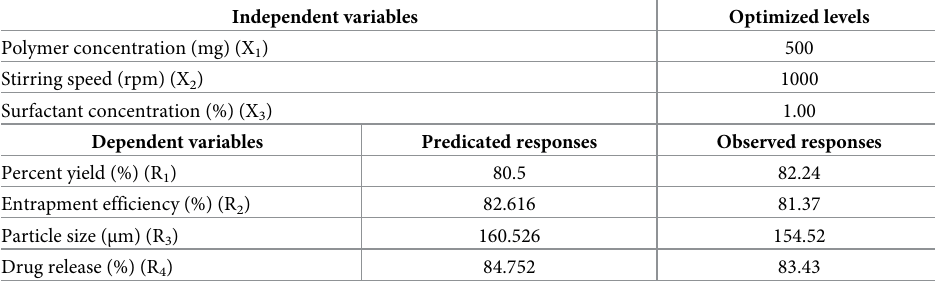
Table 5. The optimized formulation (F0) levels, predicted, and observed values.